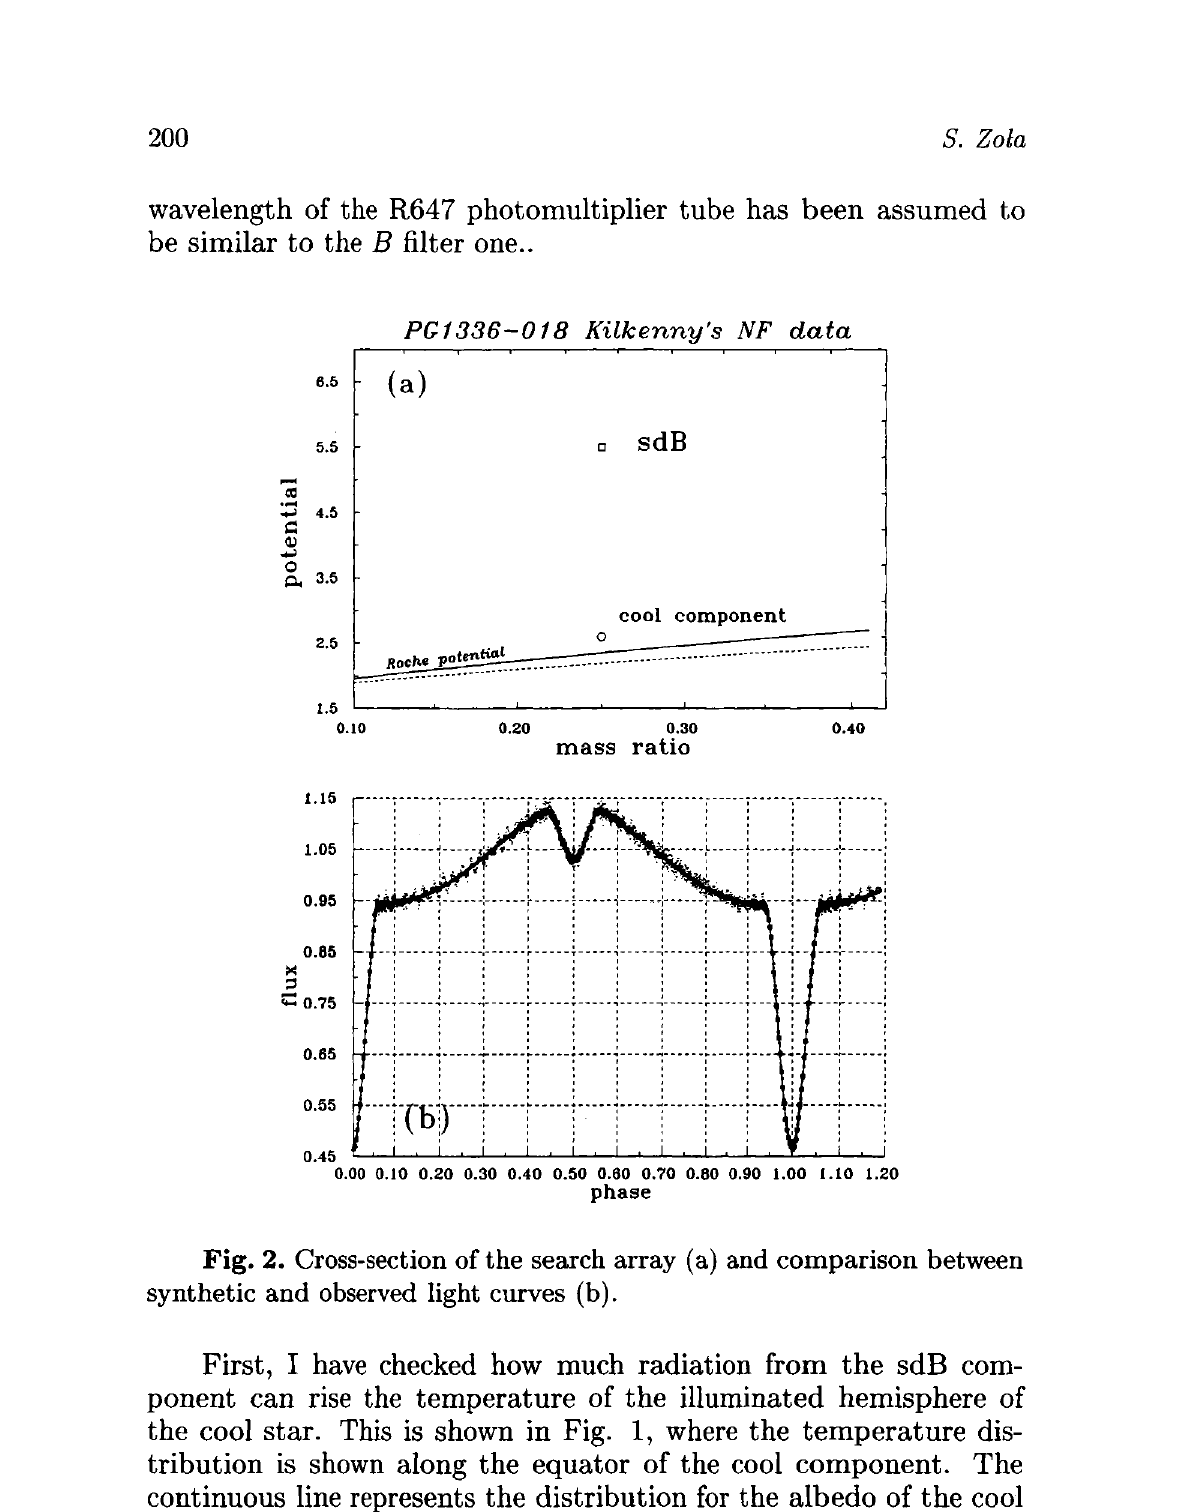
Fig. 2. Cross-section of the search array (a) and comparison between synthetic and observed light curves